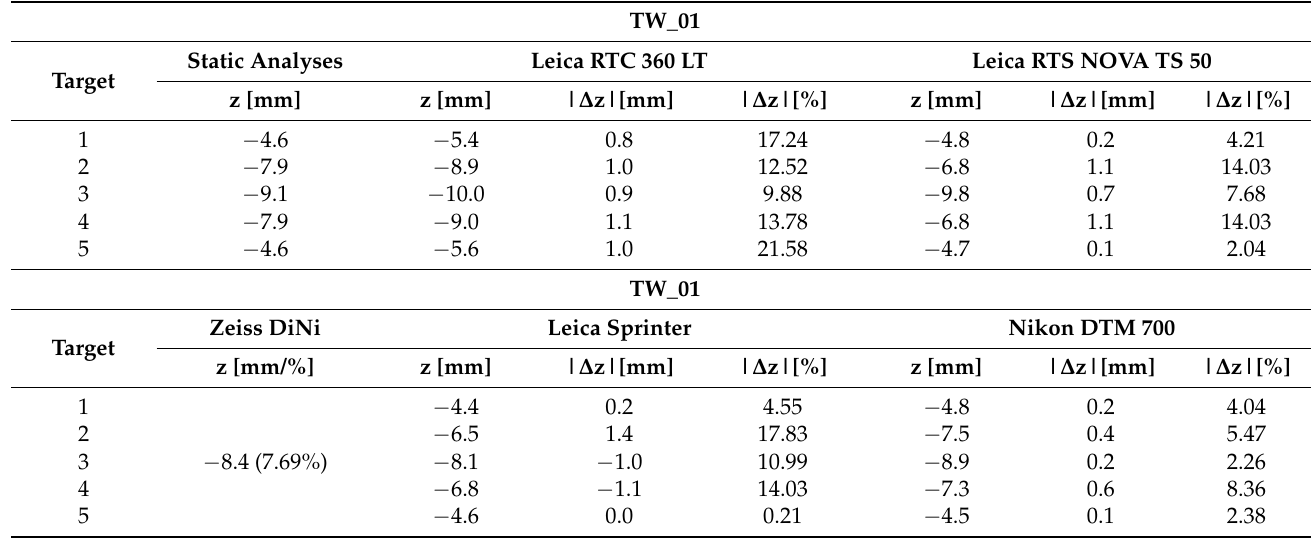
Table 5. Differences and comparisons of measurements with static analyses of the beam TW_01.